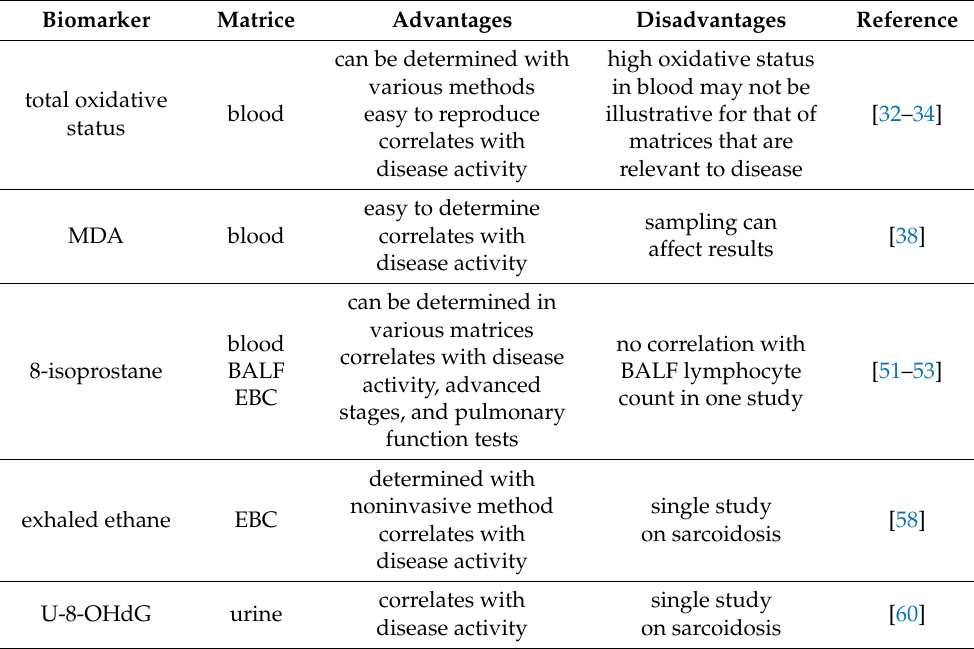
Table 1. Overview of the most important biomarkers of oxidative stress in